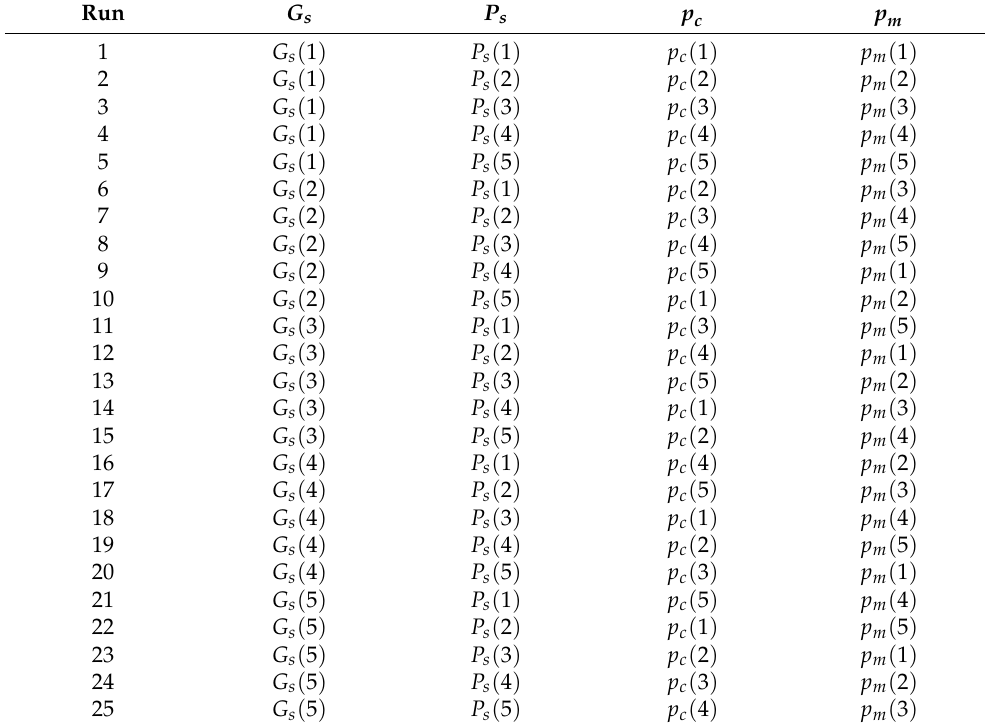
Table 3. Orthogonal arrays for GA